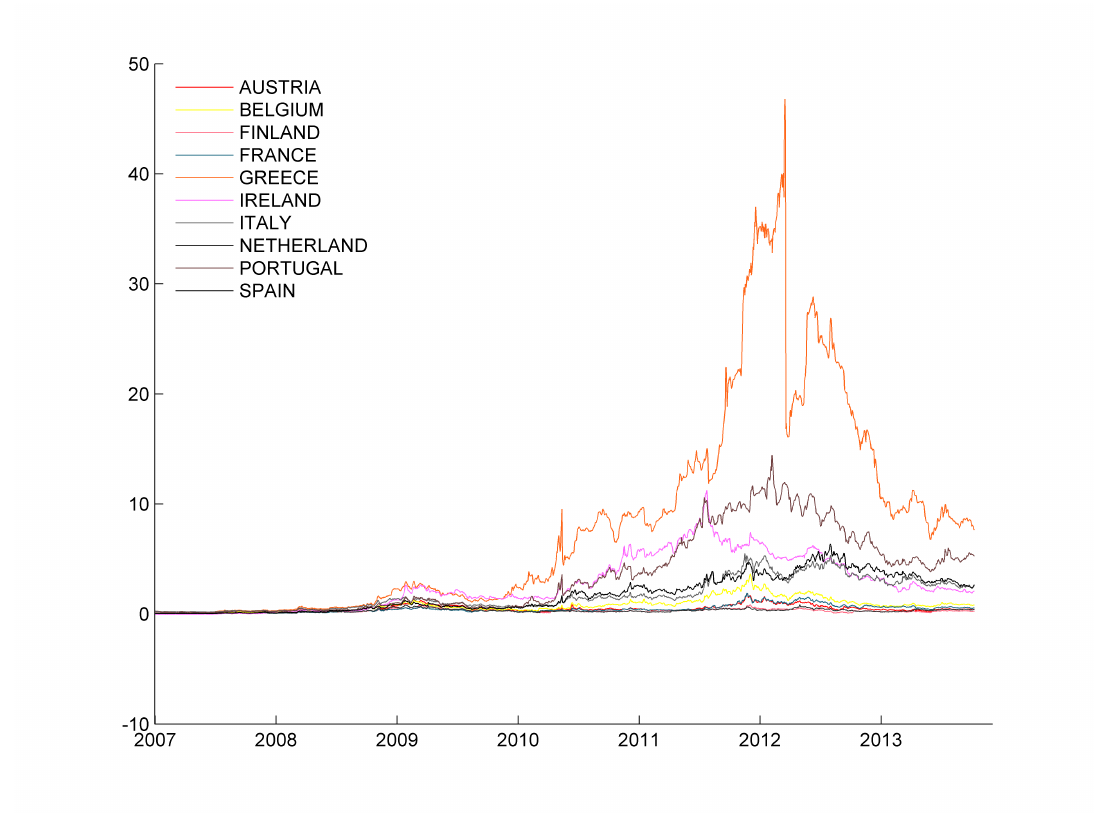
Figure 1 . Government bond yields